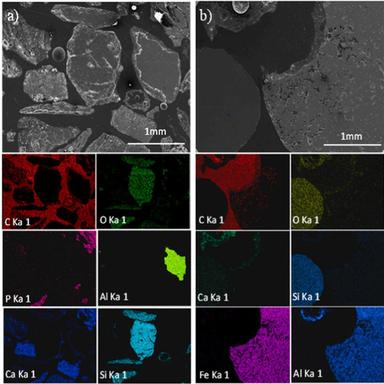
Morphology and EDX mapping of IBA particles: a) 0.3–1.18 mm; b) 1.18–6.3 mm.